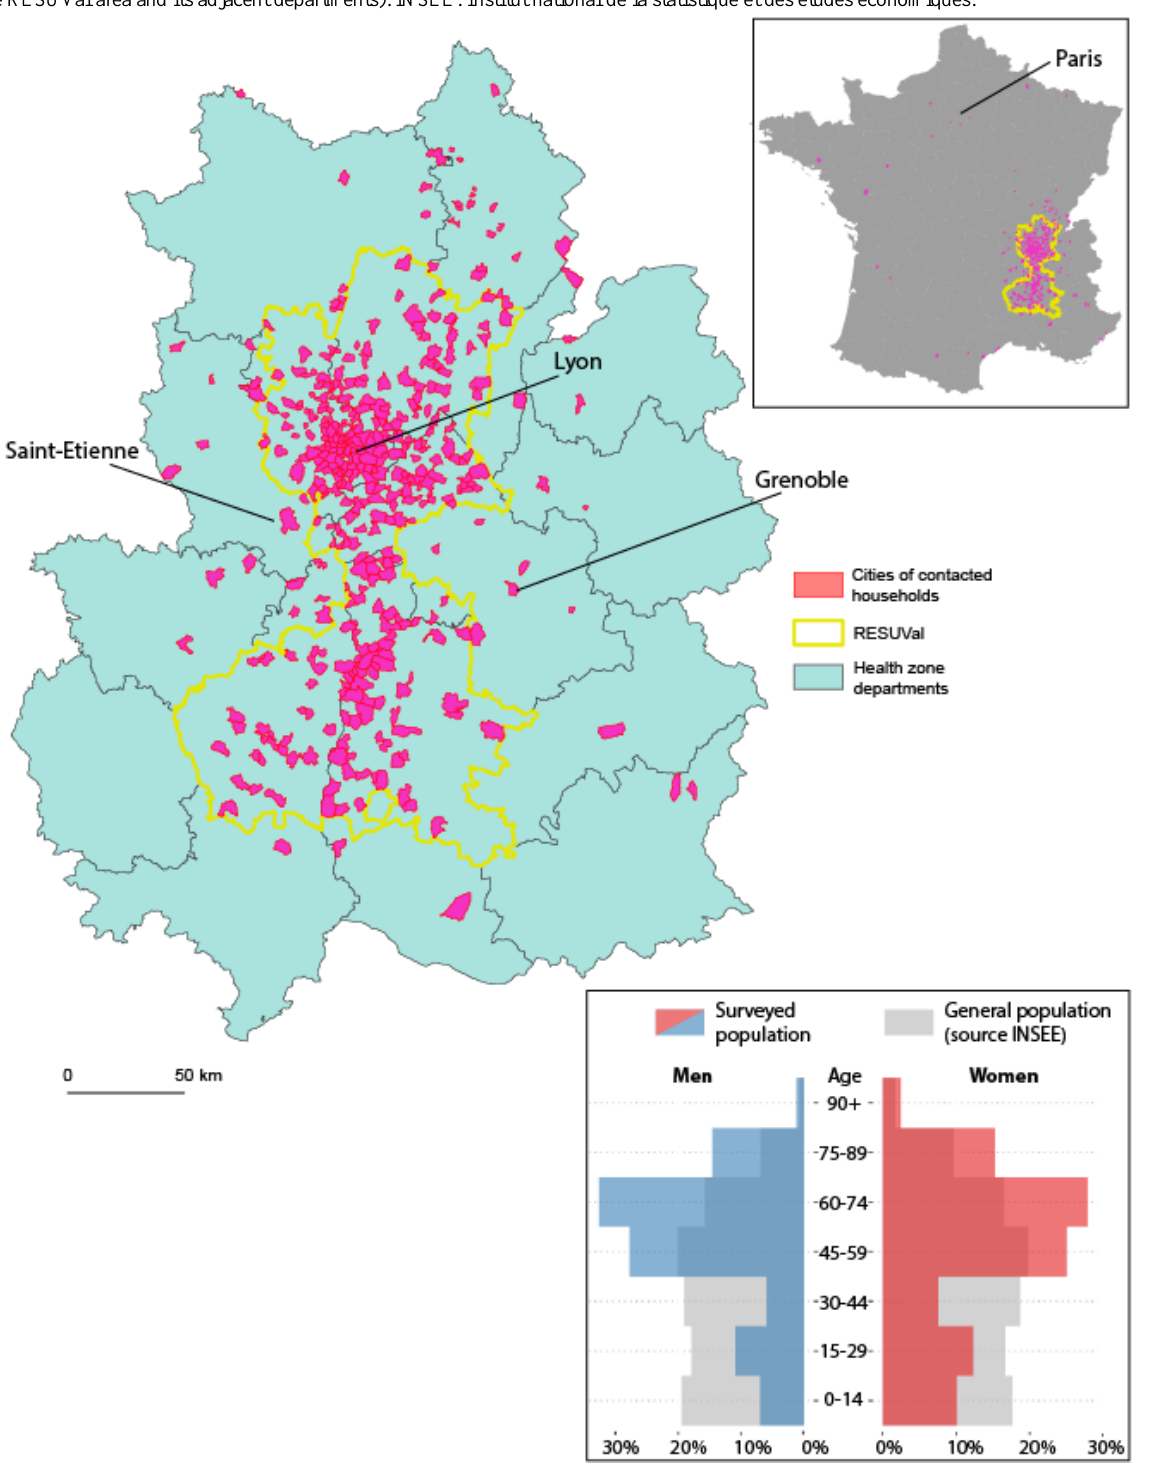
Figure 2. Territorial coverage and age and sex representativeness of the households included in the telephone survey (N=1552 in France for